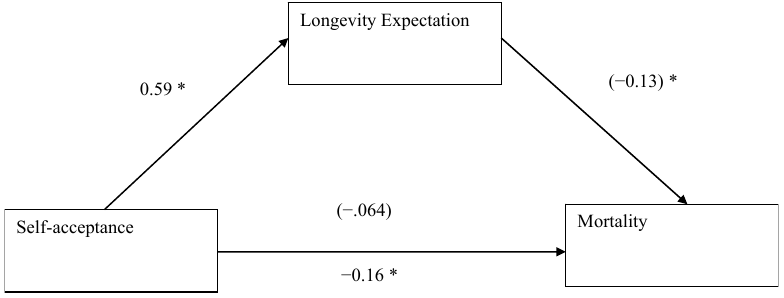
Figure 3. Longevity expectation fully mediated the association between self-acceptance and all-cause mortality (time-to-event). Parentheses denote results of hierarchical regression where longevity expectation was significant while self-acceptance was not. * p < 0.05.